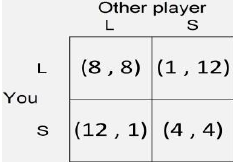
Figure 1. Example of a decision matrix used in the seqPD.